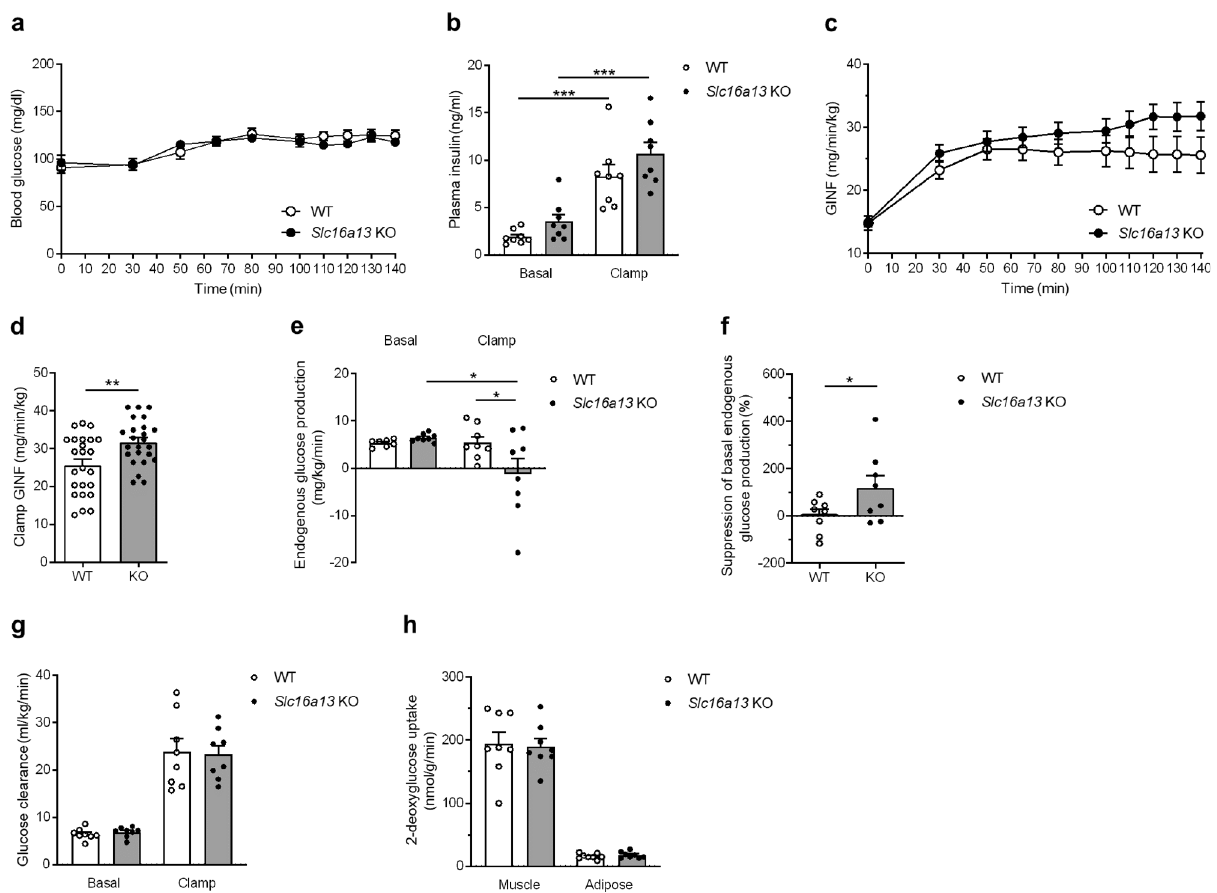
Fig. 6 Glucose metabolism of Slc16a13 knockout mice at 15 weeks of HFD. a Plasma glucose concentration during HE clamp. b Basal and clamp plasma insulin levels. c , d Glucose-infusion rate during HE clamp and in the clamped state (120 – 140 min) in WT and Slc16a13 KO mice. All three steady-state data points per mouse are shown ( d ). e , f Basal and clamp hepatic endogenous glucose production and suppression of basal endogenous glucose production in WT and Slc16a13 KO mice. g Plasma glucose clearance in WT and Slc16a13 KO mice. h 2-deoxyglucose uptake in quadriceps muscle and epigonadal white adipose tissue. Slc16a13 WT ( n = 8), Slc16a13 KO ( n = 8). a , c Means ± SEM are displayed. b , d – h Bars represent means ± SEM. * p < 0.05, ** p < 0.01, *** p < 0.001 determined using two-tailed unpaired Student ’ s t -test, except for e , f * p < 0.05 determined using one-tailed unpaired Student ’ s t